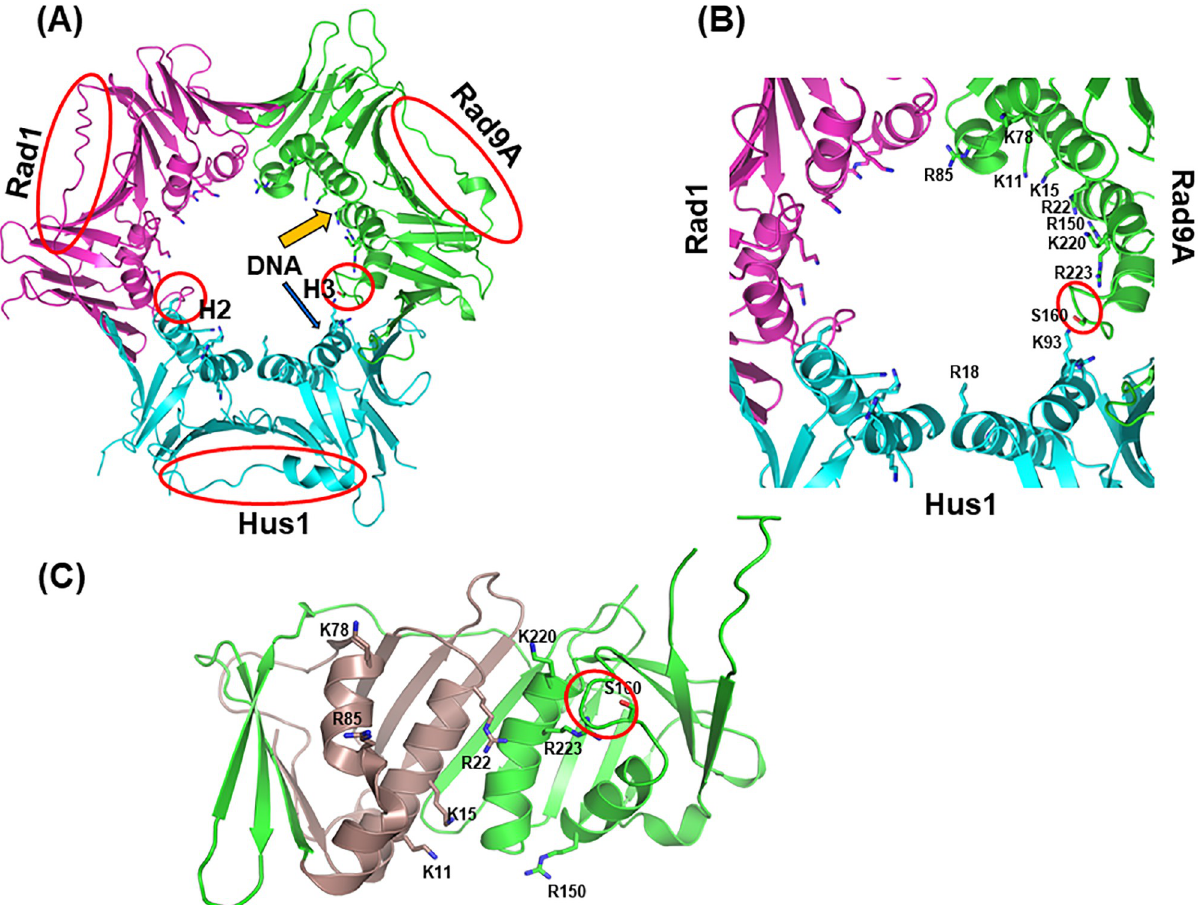
Fig 1. Structure of the 9-1-1 complex. ( A ) Top view of the human 9-1-1 complex. The crystal structure 9 1 − 272 -1-1 is shown (RCSB codes:3A1J) [37]. The extreme C-terminal domain of Rad9A (residues 267–391) is not shown because its structure has not been determined. The key differences among the three subunits are circled in red. The DNA in the inner channel of the 9-1-1 ring is bound by Rad9A and the N-terminal domain of Hus1 [43] shown in orange and blue arrows, respectively. ( B ) Basic residues and S160 of hRad9A as well as R18 and K93 of hHus1 in the channel of the 9-1-1 ring are labeled. A small loop (residues 160–163, with sequence SPAL) of hRad9A projected into the inner ring surface is circled in red. ( C ) A side view of hRad9A structure looking from inside of the ring. Residues 1–93 are colored dark violet and residues 94–266 are colored green. A small loop (residues 160–163) is circled in